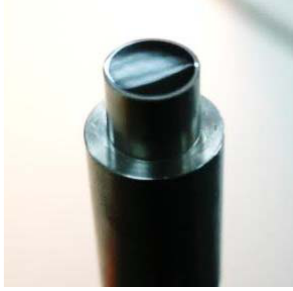
Figure 5. Polished IOFB containing approximately 50,000